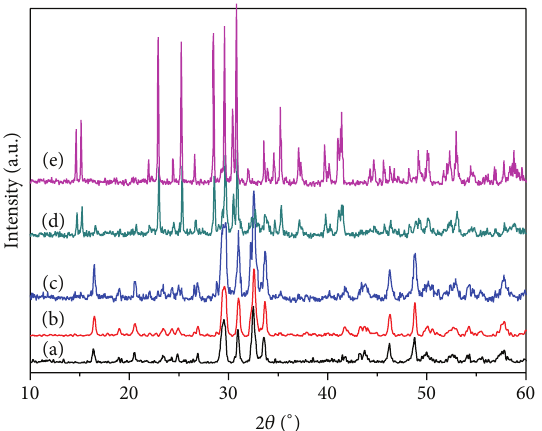
Figure1:XRDpatternsofPr:Y 2 SiO 5 dopeddifferentconcentrations of Li(I). (a) 0%; (b) 2%; (c) 6%; (d) 8%; (e) 10%.